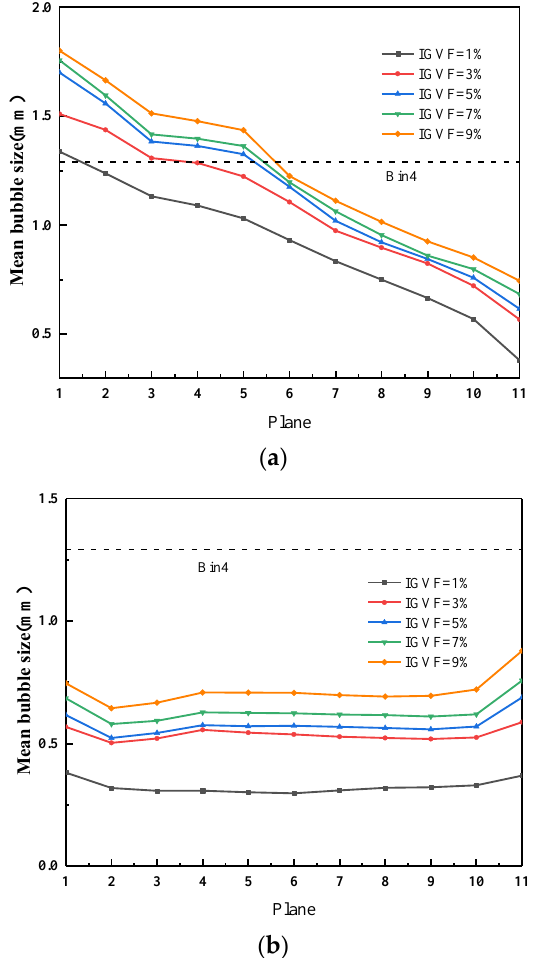
Figure 12. Bubble size distribution along axial sections of pressurization unit of multiphase pump under different gas – liquid two-phase media with different IGVF conditions. ( a ) Bubble size distribution of impeller along axial sections. ( b ) Bubble size distribution of diffuser along axial sections.